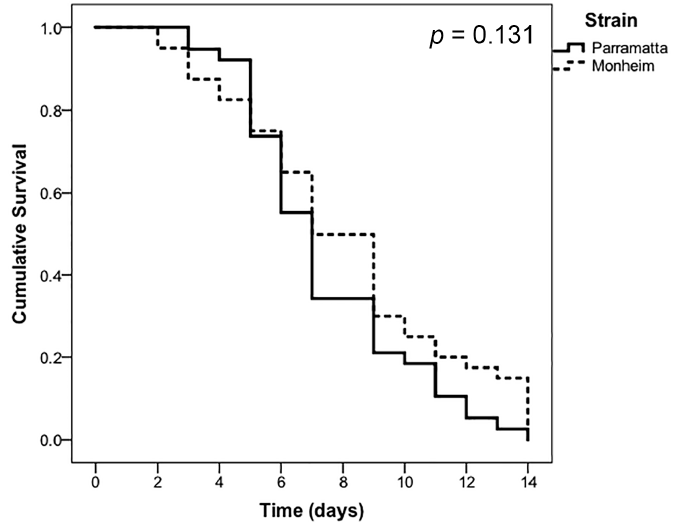
Figure 3. Proportional cumulative survival in response to continuous exposure to the prescribed label rate of Bed Bug Killer Powder of Parramatta (resistant) and Monheim (susceptible) strains of Cimex lectularius ( n = 40 bugs per strain, control mortality at 14 days (both strains) ≤ 5%). Estimates of the LT 50 values for CimeXa (Table 2) also indicated no statistically significant difference between the Parramatta (resistant) and Monheim (susceptible) bugs when exposed to the prescribed label rate, with 50% mortality expected after ≈ 20 h of continuous exposure. However, at half label rate of CimeXa the estimated LT 50 value for Parramatta (resistant) bugs (30 h), was ≈ 50% more than that of the Monheim (susceptible) bugs (20.47 h). Failure of the 95% confidence intervals to overlap for these values indicates that this is, putatively, a statistically significant difference. Table 2. LT 50 values in hours (±95% confidence intervals) for Parramatta (resistant) and Monheim (susceptible) Cimex lectularius when assayed against CimeXa Insecticide Dust (at 1.0× and 0.5× label rate).